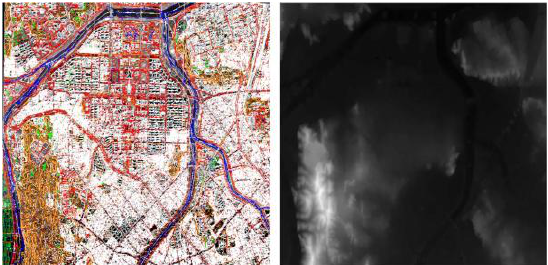
Figure 4. The reference digital map and extracted DEM